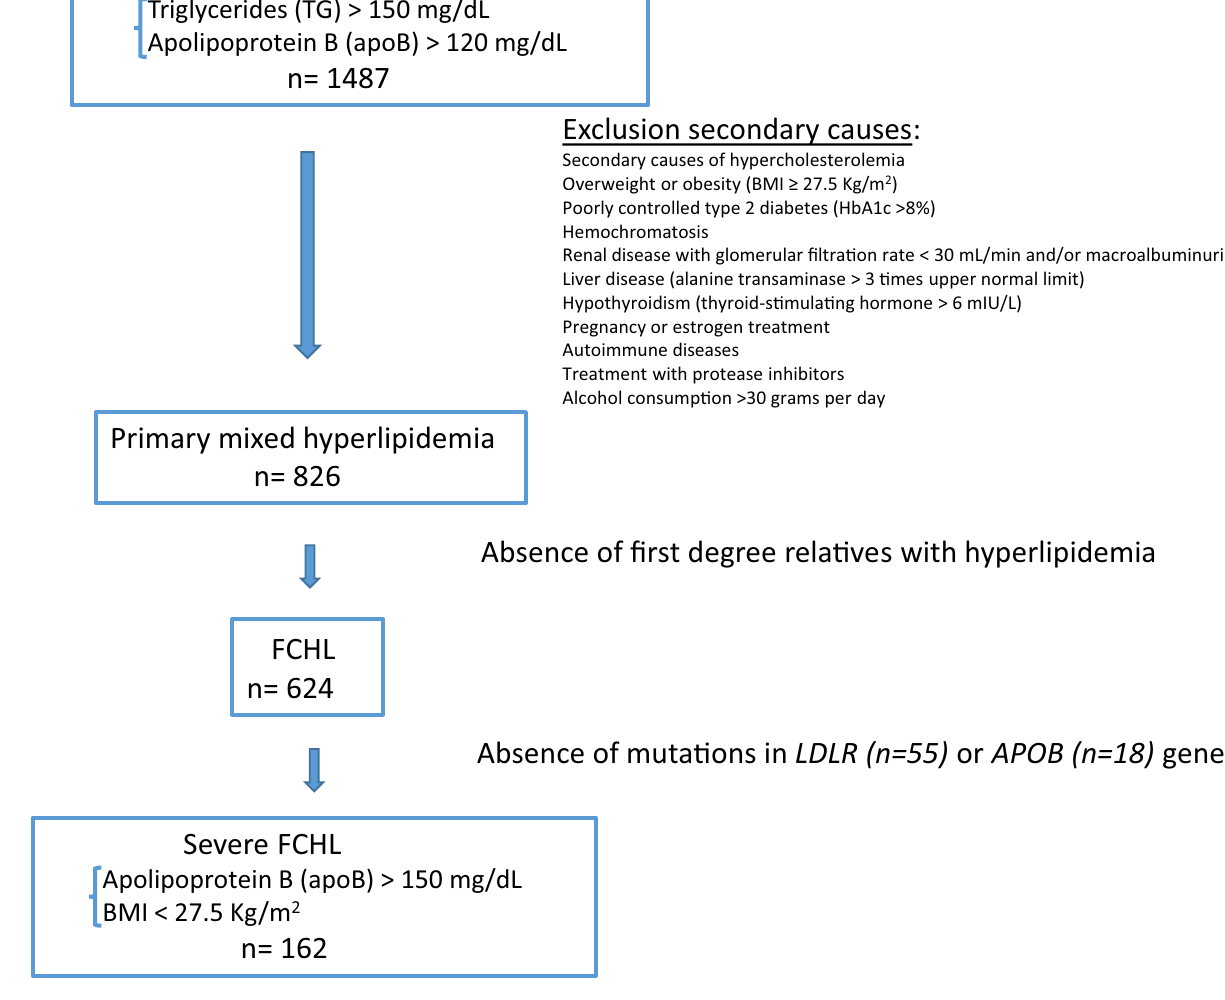
Figure 1. Flow chart of subject selection